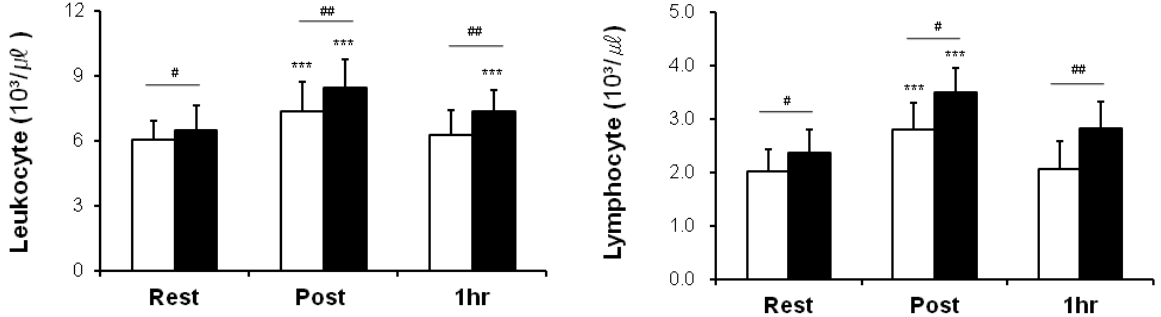
Figure 2. Leukocytes and lymphocytes over time in two groups. Rest: before heating; Post: immediately after heating; 1 h: 1 h after heating. White columns indicate placebo intake, and black columns, oligonol intake. Values are presented as the mean ± standard deviation. *** p < 0.001 indicates a significant difference in comparison to Rest within the same group, and # p < 0.05 and ## p < 0.01 indicate significant differences between two groups.